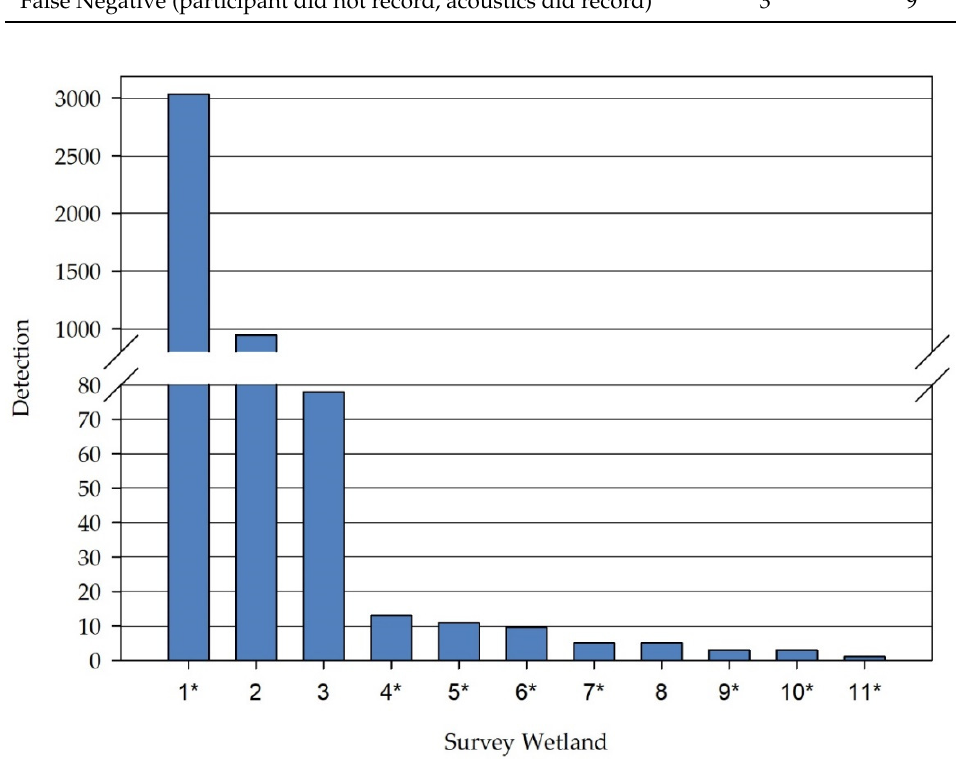
Figure 3. Autonomous recording unit (ARU) detections for wood frog at 12 wetland sites in Calgary, AB, Canada whereby * indicates sites where wood frogs were not reported by citizen scientists (only 11 sites are displayed because wetland 6 was a repeat monitoring site and citizen scientists missed recording wood frog both years, displayed here as average number of detections). Of those sites where wood frogs were not reported by citizen scientists, only wetland 1 had greater than 15 recorded calls during the duration of the season. Four wetland sites with no recorded wood frog detections are not displayed on the